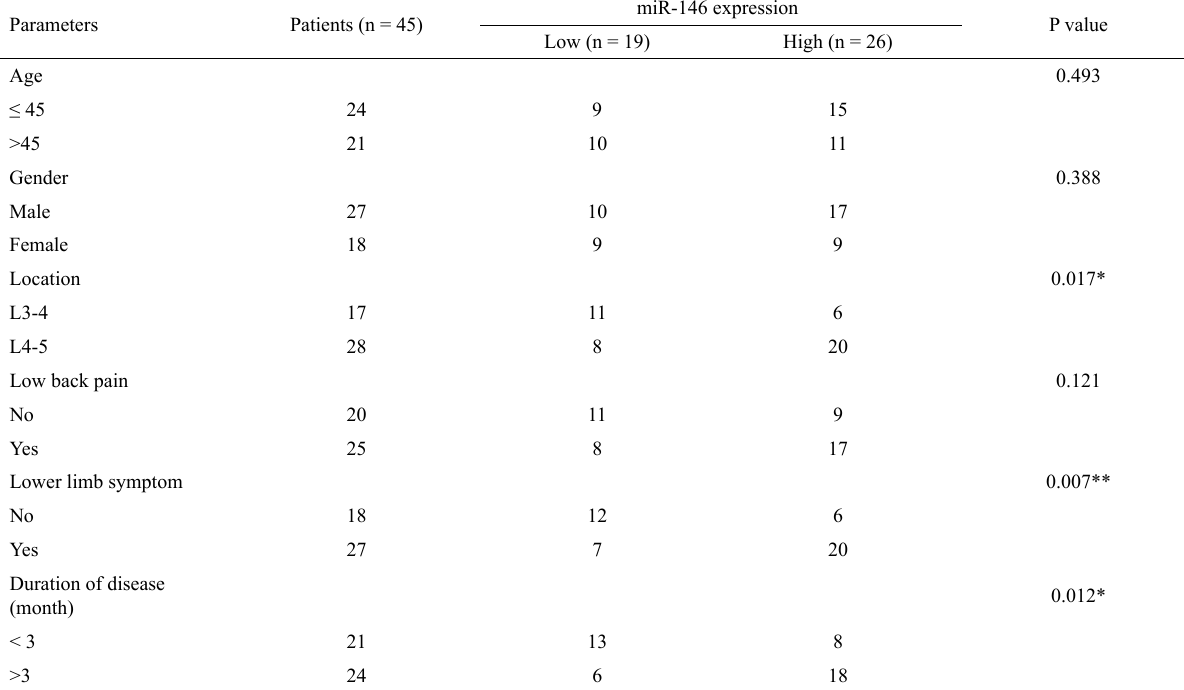
Table 1 – Association between miR-146 expression and clinical features of patients with epidural fibrosis. Parameters Patients (n =